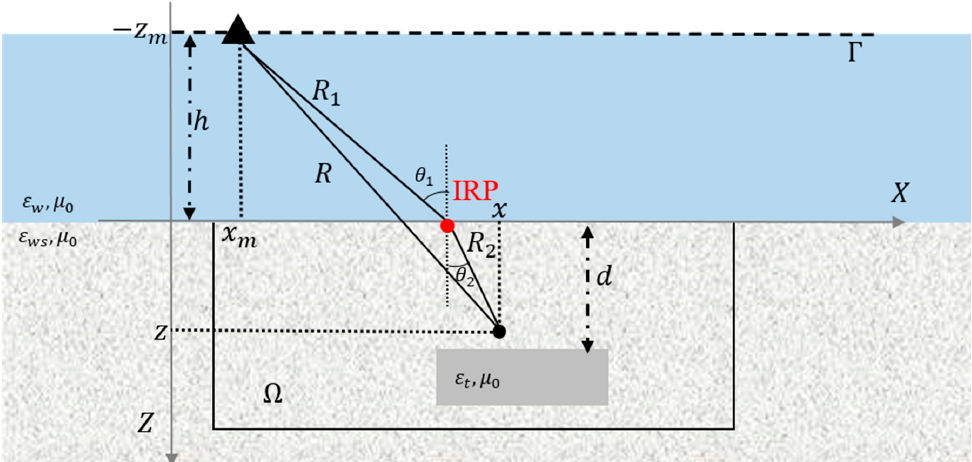
Figure 1. Reference scenario.